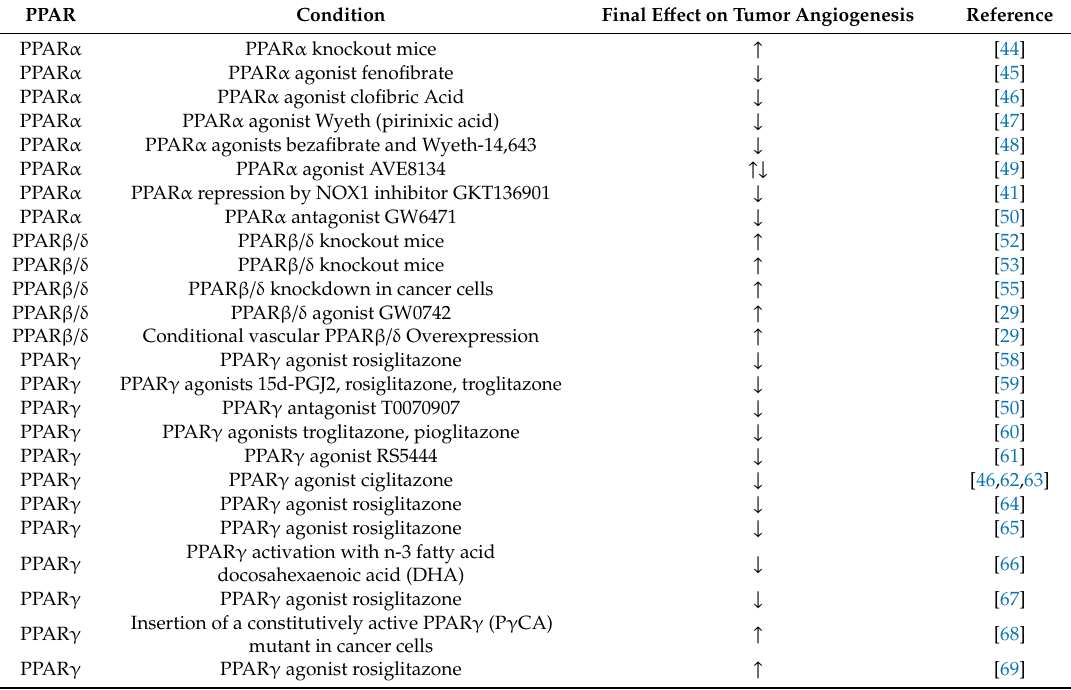
Table 1. PPAR Modulation in in vivo Studies of Tumor